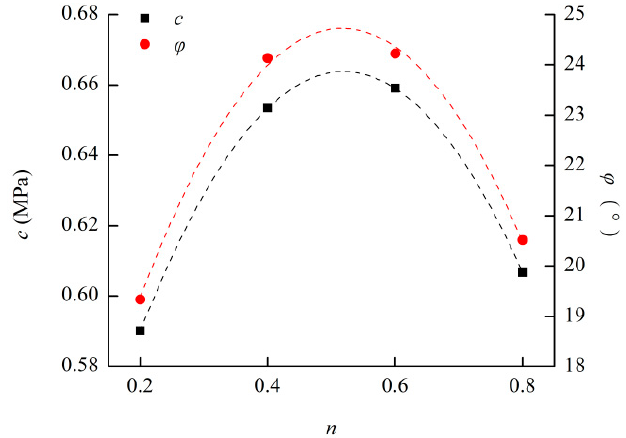
Figure 5. Relationship between the compressive strength and Talbot index.